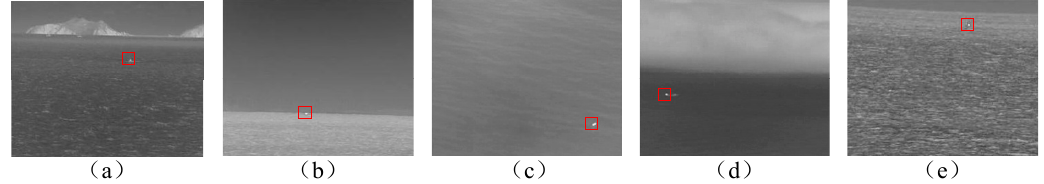
Figure 14. Five types of typical maritime images: ( a ) island interference in the image; ( b ) target on the horizon line; ( c ) target on the calm sea; ( d ) fog interference in the image; ( e ) target on the sea with obvious